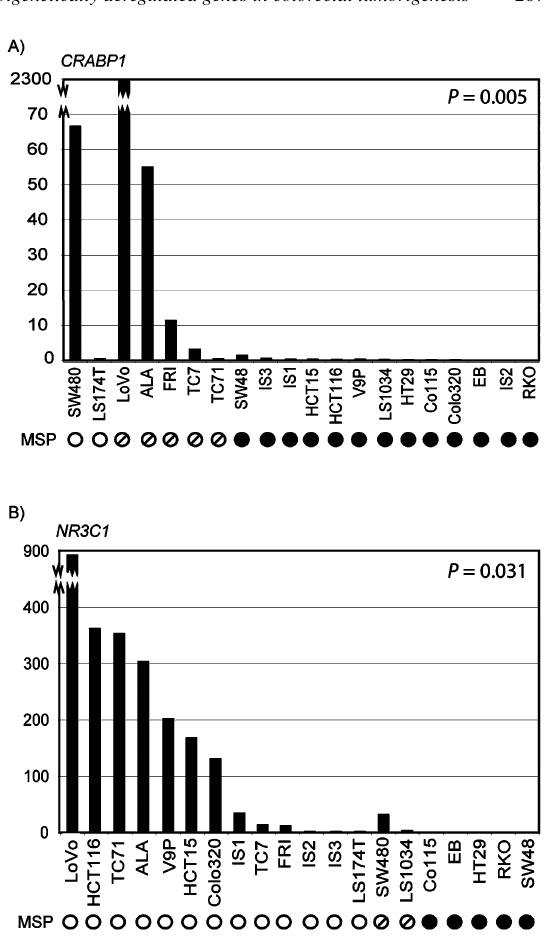
Fig. 4. CRABP1 ( A ), and NR3C1 ( B ) expression in colon cancer cell lines. The quantitative expression levels are displayed as ratios between the specified gene and the endogenous control PGK1 mul- tiplied by a factor of 1000. The CpG island hypermethylation sta- tus assessed by methylation-specific PCR (MSP) is shown below each chart. Filled circles represent methylated CpGs, open circles represent unmethylated CpGs, and open circles with a slash repre- sent presence of both methylated and unmethylated alleles. For both genes, promoter hypermethylation was associated with reduced or lost gene expression ( P value listed in the right corner of each panel). shown). For CRABP1 , there was a strong associa- tion between gene expression and methylation status ( P = 0 . 005). Cell lines containing both methylated and unmethylated DNA molecules revealed the high- est CRABP1 expression. Promoter hypermethylation to